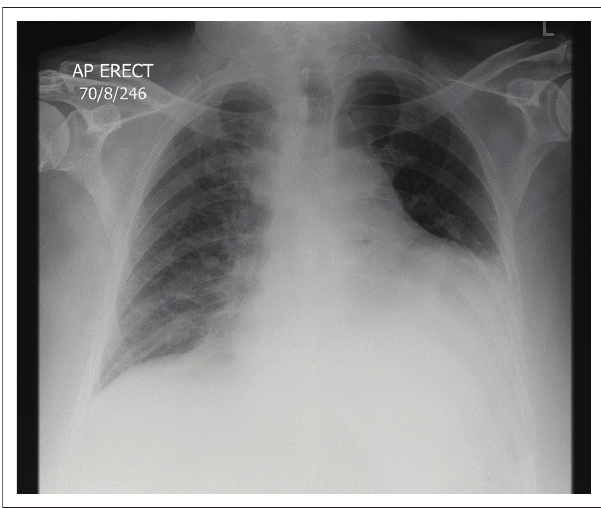
FIGURE 3: Repeat chest X-ray showing recurrent pericardial effusion.